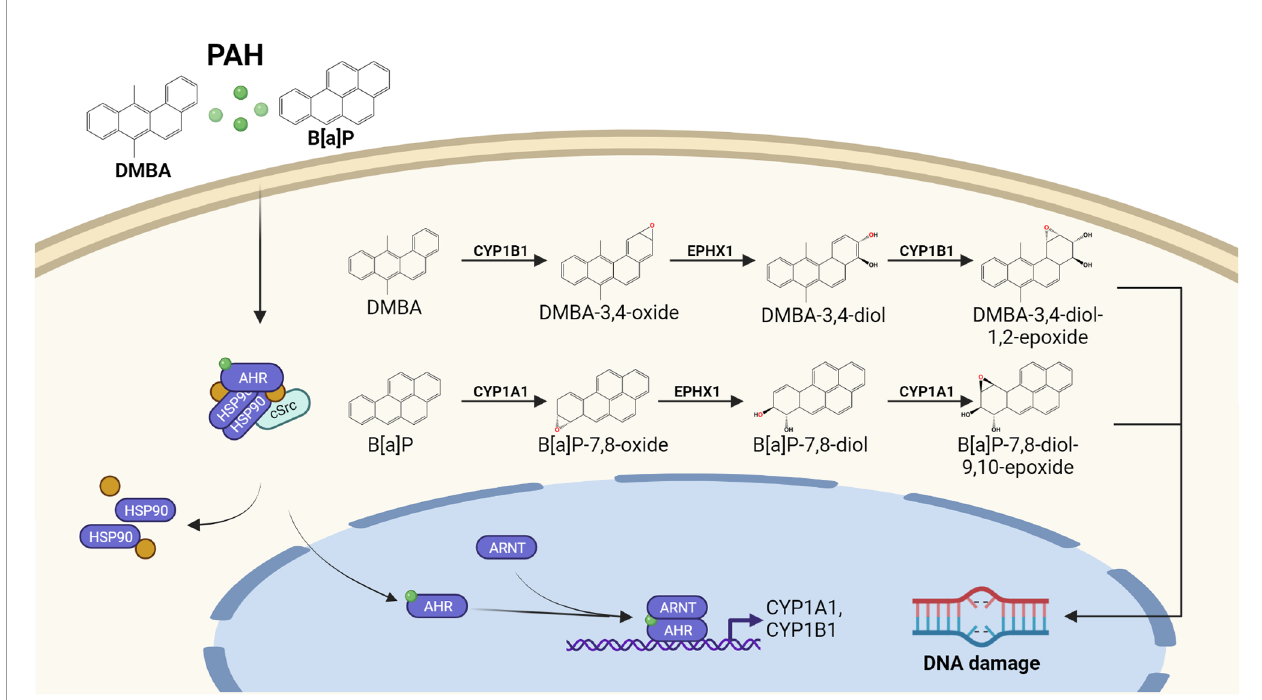
FIGURE 2 | AHR-dependent metabolic activation of PAHs by CYP1 isoforms. Lipophilic PAHs can easily pass the plasma membrane and activate the canonical AHR signaling pathway. The resulting induction of CYP1 isoform expression and enzyme activity accelerates the oxidative metabolism of the invading chemicals. In case a proper detoxi fi cation of the resulting reactive PAH metabolites by the conjugating enzyme system (not shown) fails, reactive PAH-diol epoxides may covalently bind to the DNA and form highly mutagenic bulky DNA